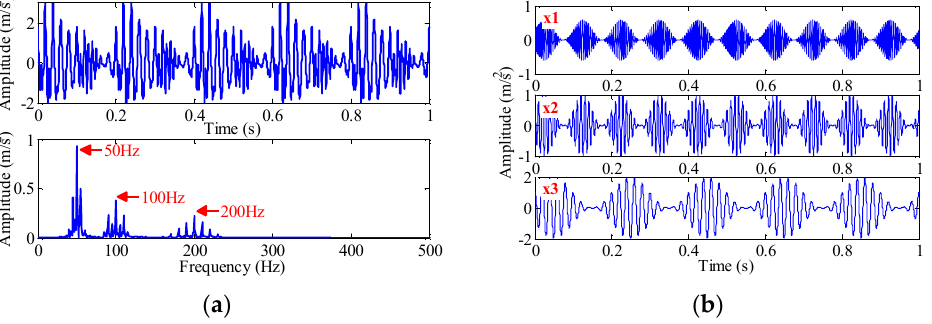
Figure 5. ( a ) Simulated signal x ( t ) and its frequency-domain waveform, and ( b ) its three components. The signal is decomposed by EEMD, VMD and TVF-EMD. The noise amplitude of EEMD is set to 0.3 and the integration number is 500 [18]. Since the signal x ( t ) contains three components, the number of modes of the VMD is three and the penalty factor is 2000. The bandwidth threshold and B-spline order of TVF-EMD are 0.1 and 20, respectively. The results are shown in Figure